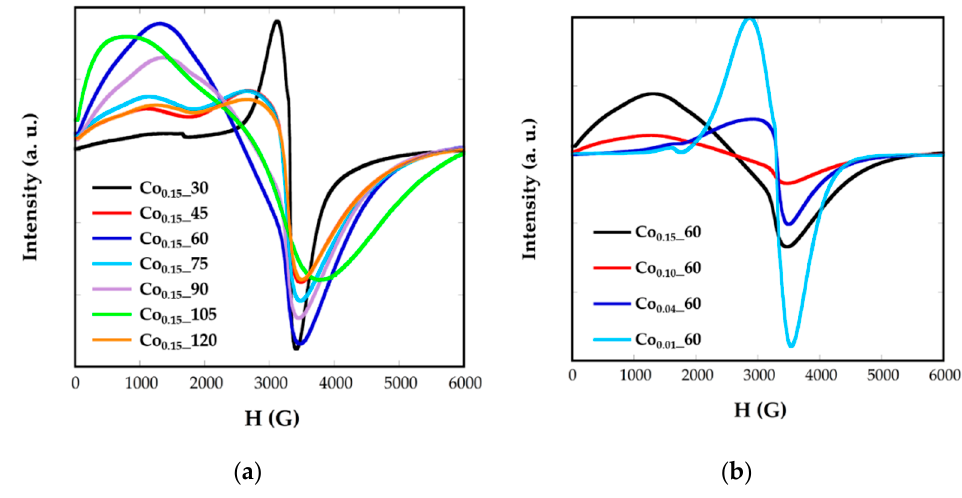
Figure 7. EMR spectra for synthetized samples Co x _ t at different ( a ) reflux times and ( b ) Co concentrations.